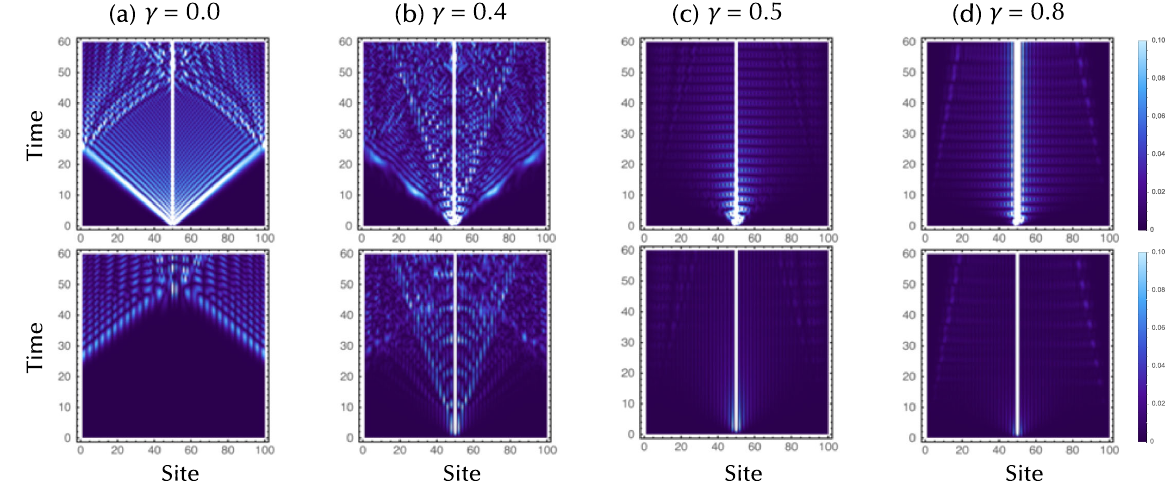
FIG. 9. Correlation propagation in the symplectic Hatano-Nelson model with open boundaries ( L ¼ 100 , J ¼ 1 . 0 ; Δ ¼ 0 . 5 ). The absolute values j C l ↑ ;l j ¼ j C l ↓ ;l j (top panels) and j C l ↑ ;l j ¼ j C l ↓ ;l j (bottom panels) of the correlation matrix are shown as a function 0 ↑ 0 ↓ 0 ↓ 0 ↑ of site l and time t with l 0 ¼ L= 2 ¼ 50 . The initial state is prepared as Eq. (24). Non-Hermiticity is chosen to be (a) γ ¼ 0 . 0 , (b) γ ¼ 0 . 4 , (c) γ ¼ 0 . 5 , and (d) γ ¼ 0 . 8 .